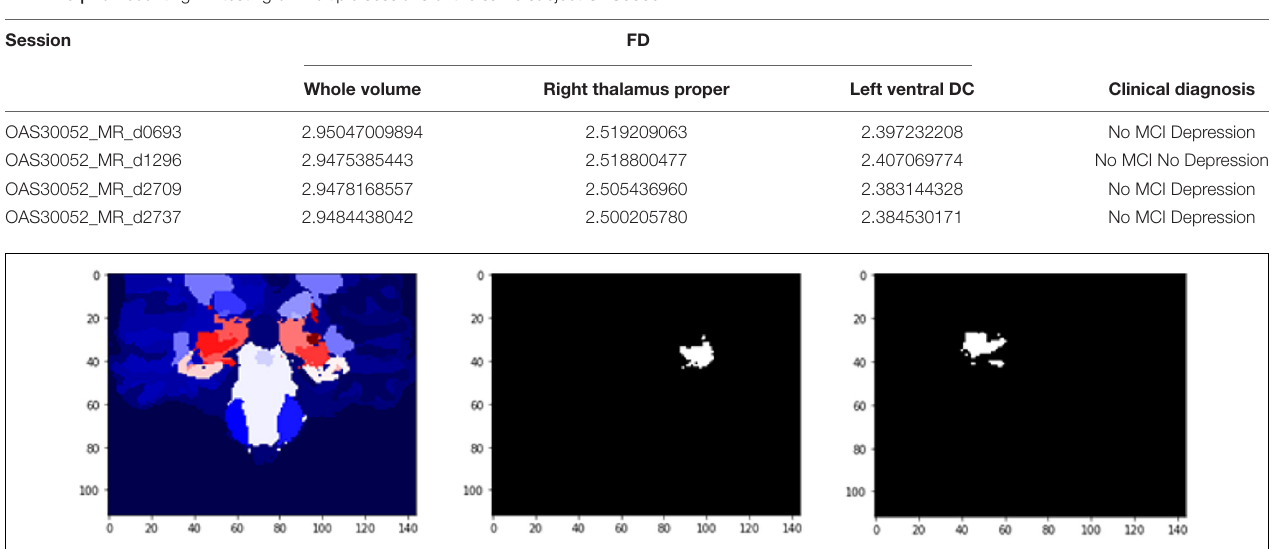
TABLE 5 | Box-counting FD testing on multiple sessions of the same subject OAS30052.